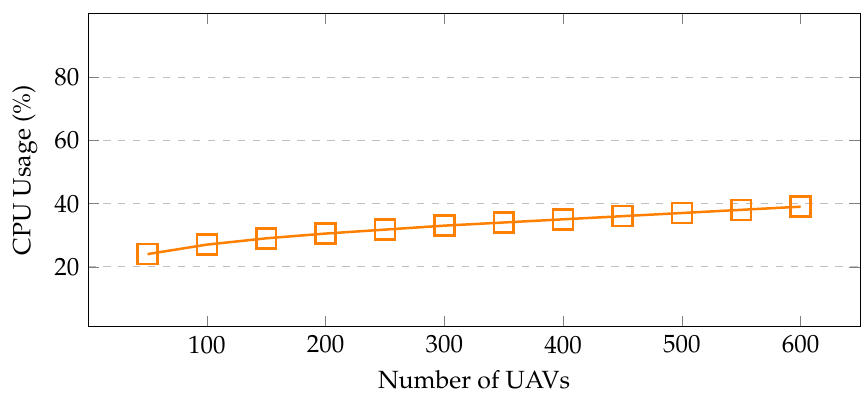
Figure 9. CPU Utilization with Increasing UAVs.